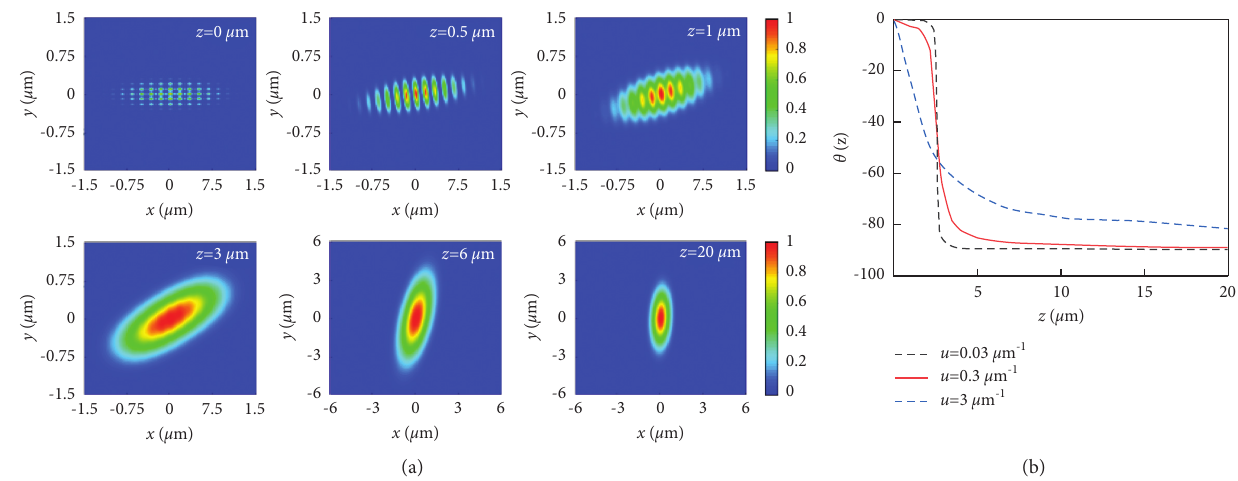
Figure 5: Variation of the DOC of the TGSMA beam in turbulent biological tissues; (a) modulus of the DOC at several propagation distances; (b) rotation angle of DOC of the TGSMA beams versus propagation distance z for different value of twist